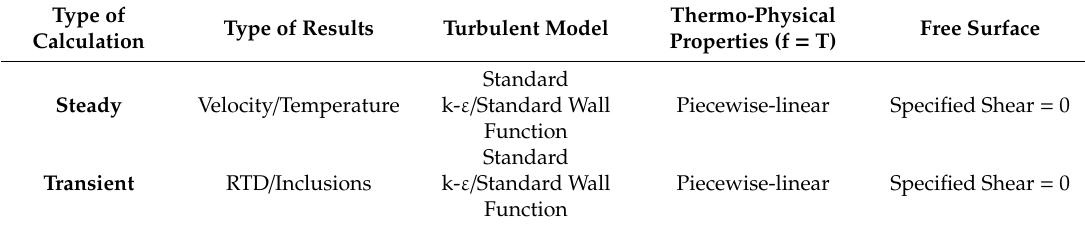
Table 3. Calculation